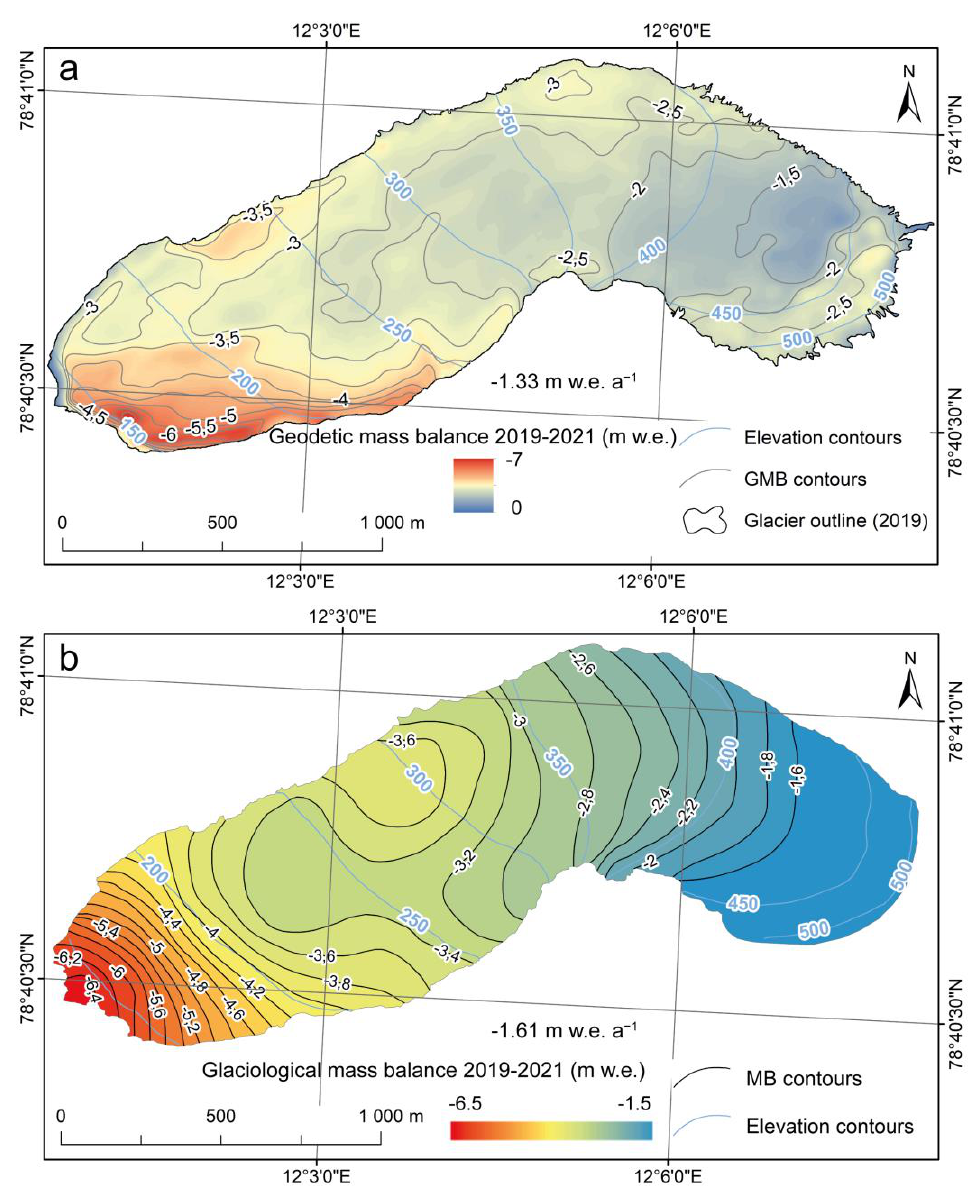
Figure 4. ( a ) Glacier-wide geodetic MB and ( b ) glaciological MB of Waldemarbreen for 2019 – 2021.